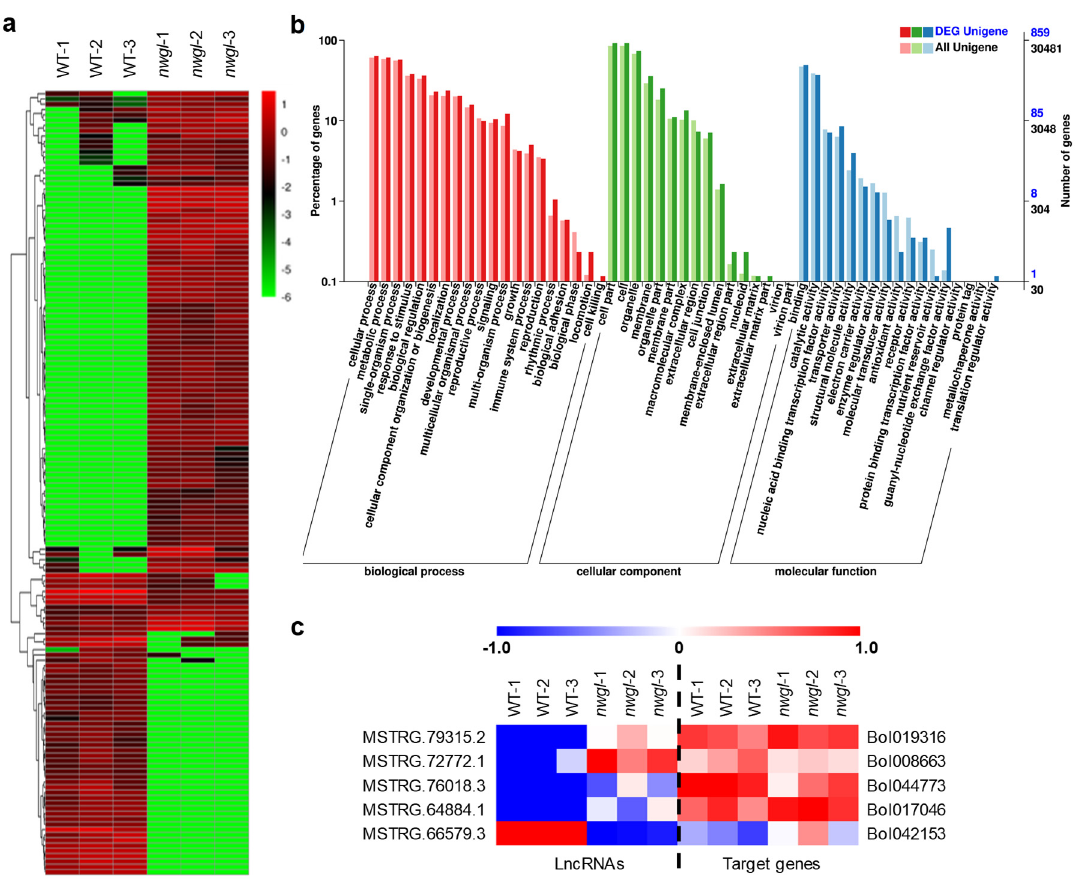
Figure 6. Di ff erentially expressed lncRNAs in nwgl vs. wild-type plants. ( a ) Hierarchical clustering analysis of the di ff erentially expressed lncRNAs. The data are expressed in base 10 logarithmic form (log10 FPKM + 0.000001). ( b ) GO classification of 906 cis -regulated target genes of di ff erentially expressed lncRNAs. ( c ) The co-expression di ff erentially expressed lncRNAs and target genes involved in lipid-related processes. The data are exhibited in base 2 logarithmic form (log2 FPKM). Three biological replicates of wild-type (WT) and nwgl plants are